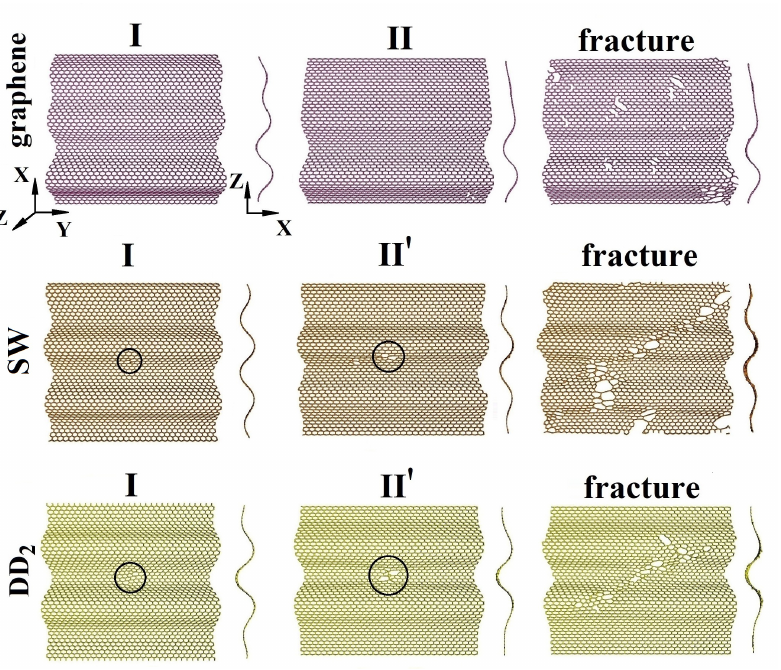
Figure 8. The same as in Figure 6, but for tension along zigzag direction. Corresponding dots I, II, II’ are presented in Figure